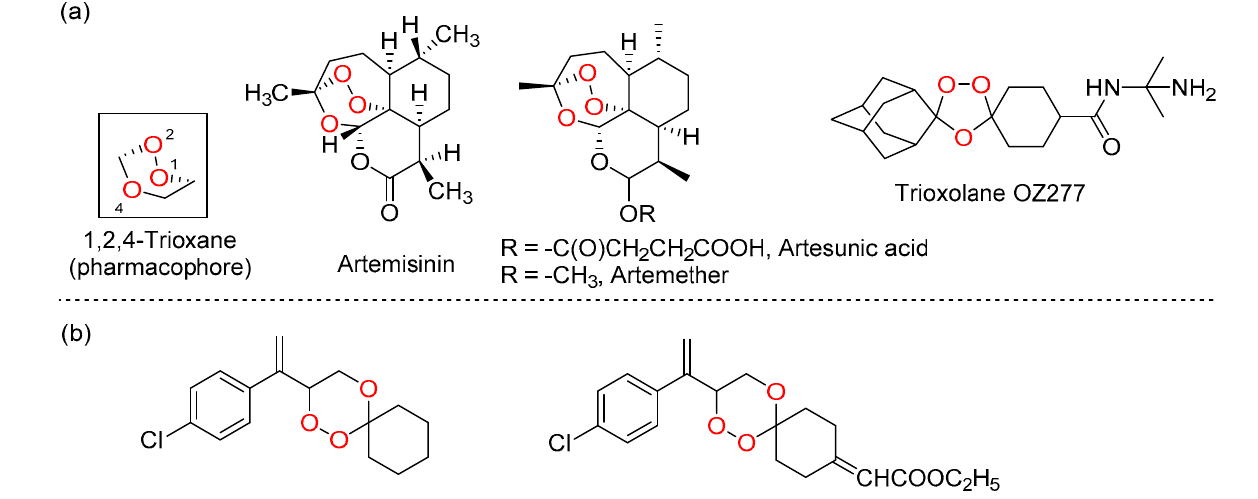
Figure 1. ( a ) Structures of artemisinin and its derivatives; ( b ) structures of synthetic halogenated arylvinyl-1,2,4-trioxanes as antimalarial agents.